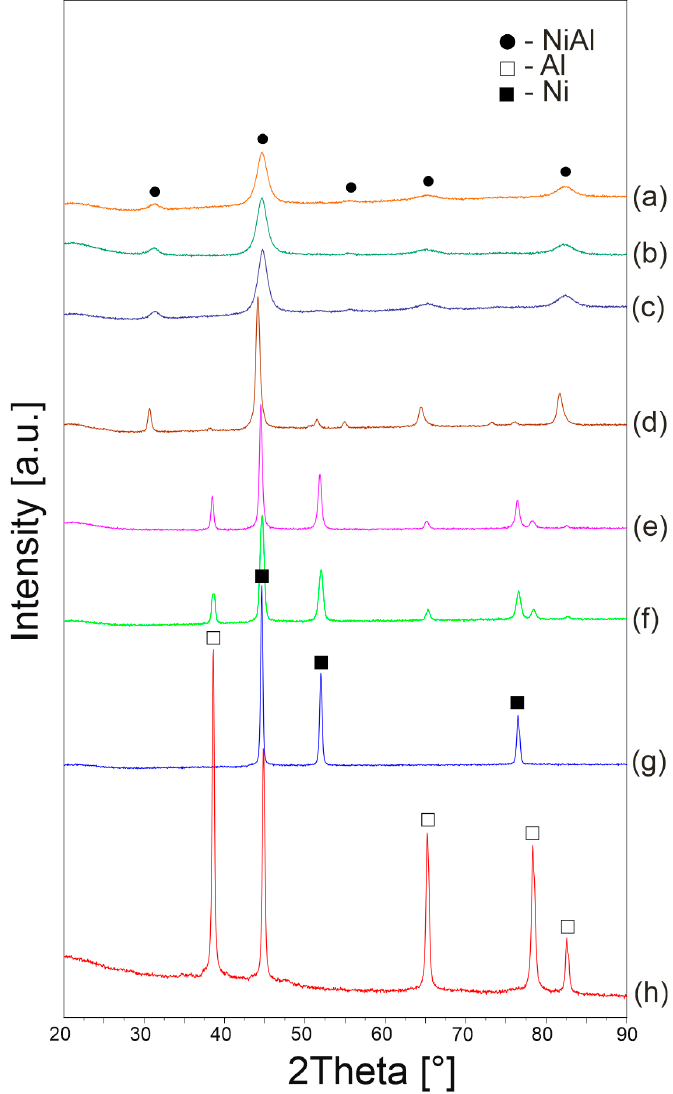
Figure 3. XRD patterns of NiAl powder after 10 h (a), 7 h (b), 5 h (c), 2 h (d), 1 h (e) and 15 min (f) of MA and XRD patterns of pure Ni (g) and Al (h). Table 2. Estimated structure size and strain factors based on Williamson–Hall plots for NiAl powders after various milling times.